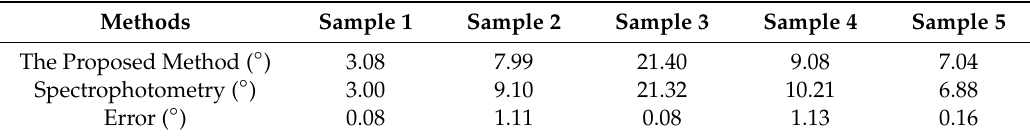
Table 3. Comparison of measurement results by two methods.